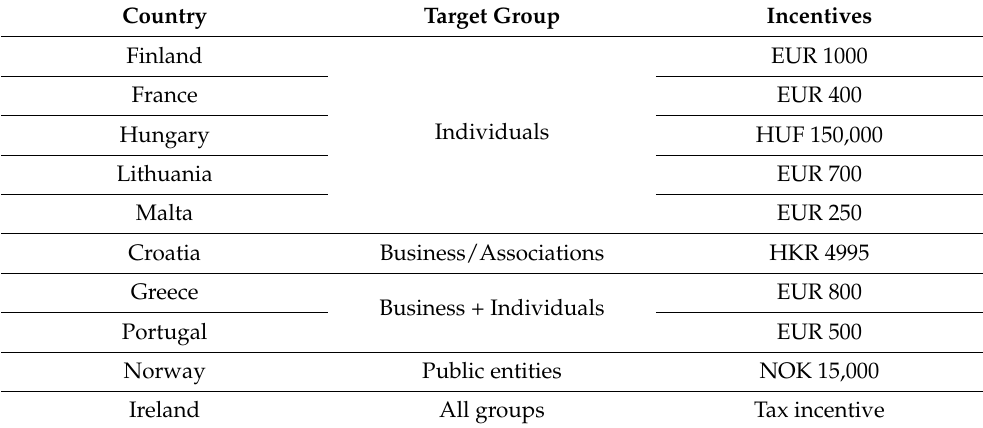
Table 1. Incentives on a national level for pedelec-25 [43]. Country Target